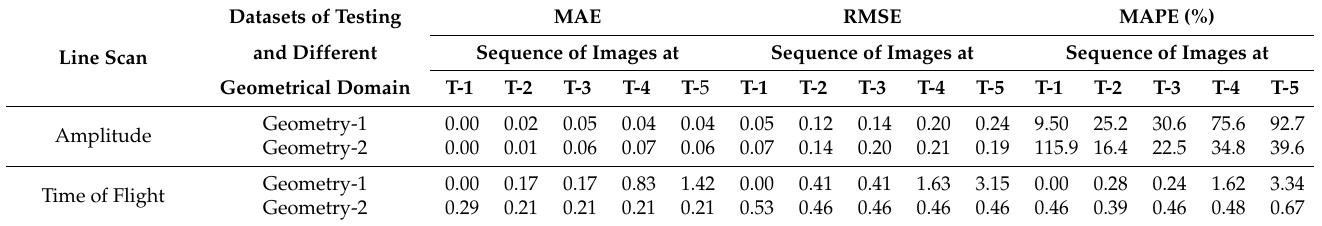
Figure 5. Line scans of different geometrical domains: the displacement values are extracted at x = 15 mm and y = 0 to 30 mm in each frame from the FE, and SDL-generated simulation of the different geometrical domains for different time instances in Figure 4. ( a ) The line scans were extracted from Figure 4a for geometry-1, and ( b ) the line scans were extracted from Figure 4b for geometry-2. Table 1. Forward wave propagation on different geometrical domains datasets: the line scan am- plitude and time of flight (TOF) differences between SDL and FE are computed using MAE, RMSE, and MAPE methods on the sequence of images at different time instances in Figure